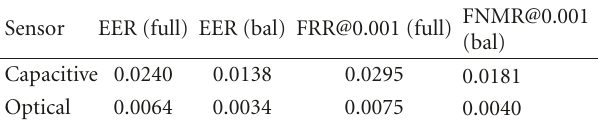
Table 1: Error rates for the two sensors and the two databases (the full database providing FRRs and the balanced database providing